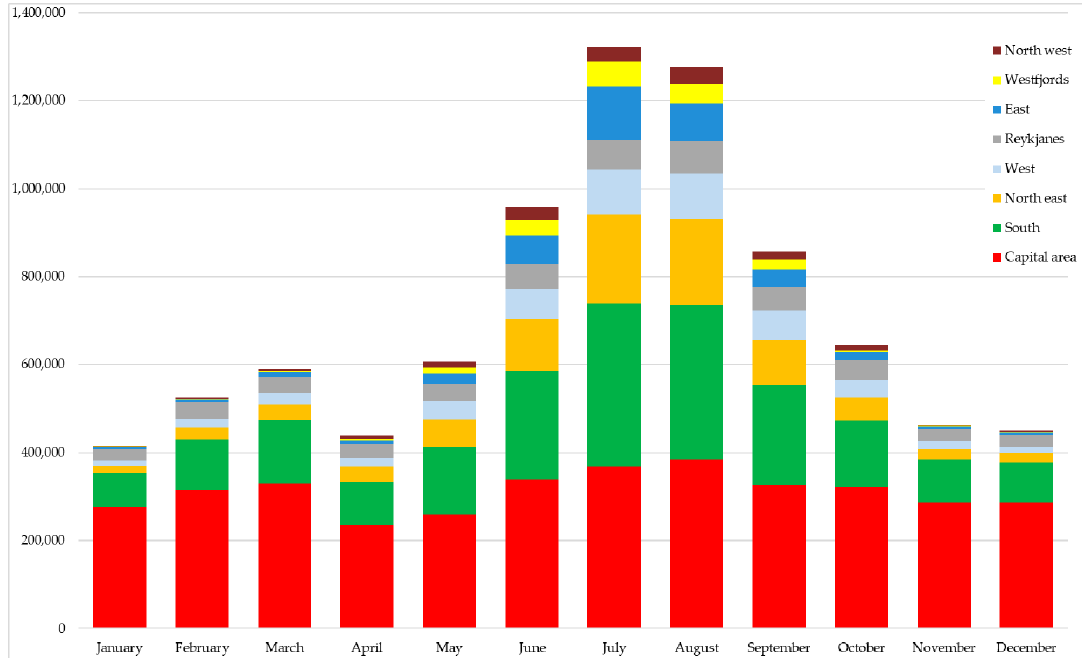
Figure 2. Overnight stays in Iceland 2018. Derived from data in: [58] .